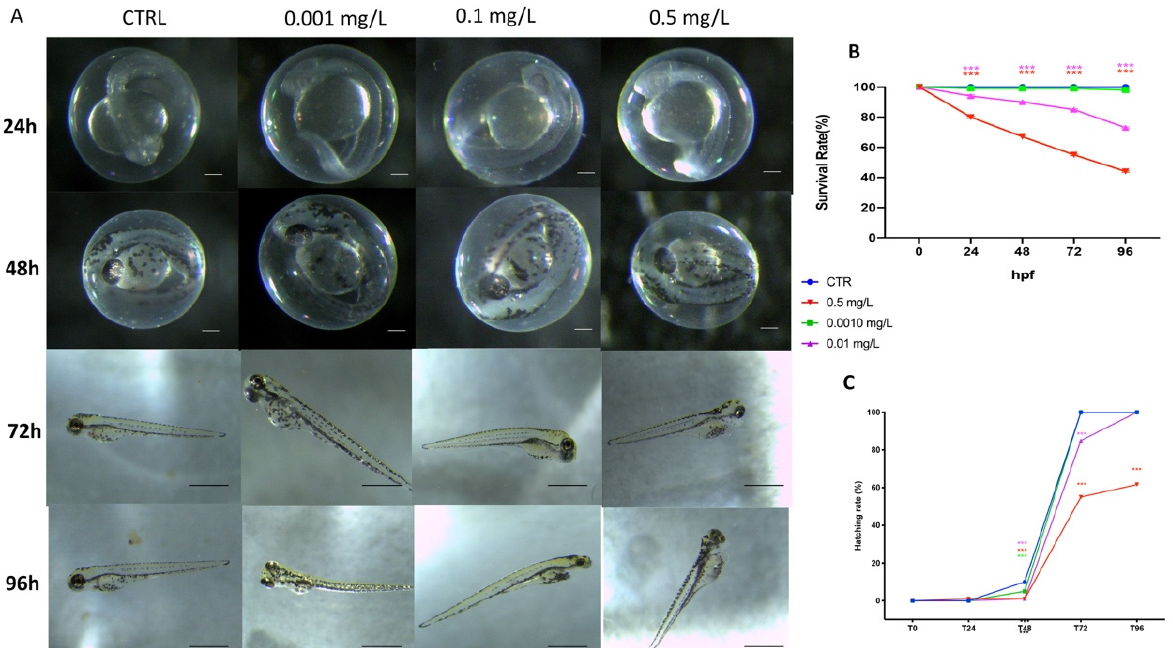
Figure 1. Embryo phenotypes, mortality and hatching rate after 24 to 96 h of exposure to OXA. ( A ) The embryo phenotypes in the unexposed and OXA-exposed groups. ( B ) The mortality rate in zebrafish embryos exposed to OXA. ( C ) The hatching rate in zebrafish embryos exposed to OXA. The asterisk denotes a statistically significant difference when compared with the CTRL: *** p < 0.001 versus control.